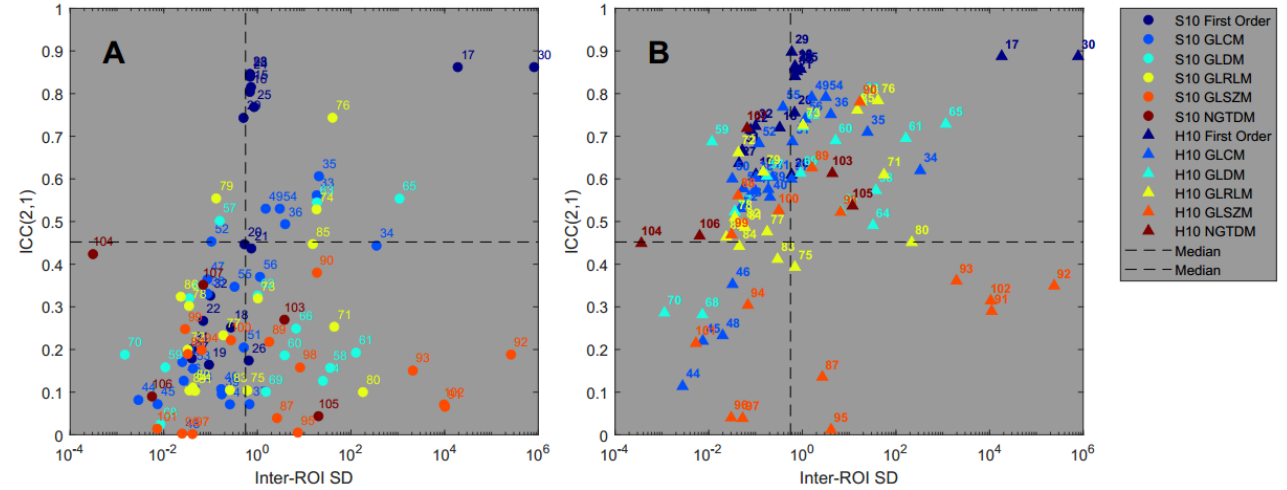
Figure 6. Feature reproducibility across different scanners (ICC(2,1)) versus pattern sensitivity (inter-ROI standard deviation) for all features in the standard ( A ) and harmonized ( B ) datasets.